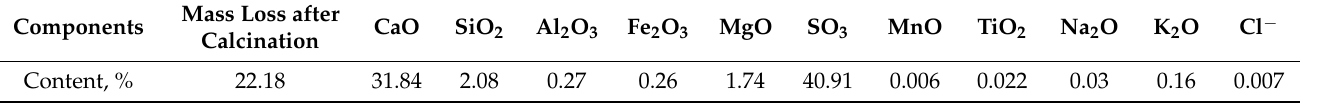
Table 3. Chemical composition of gypsum